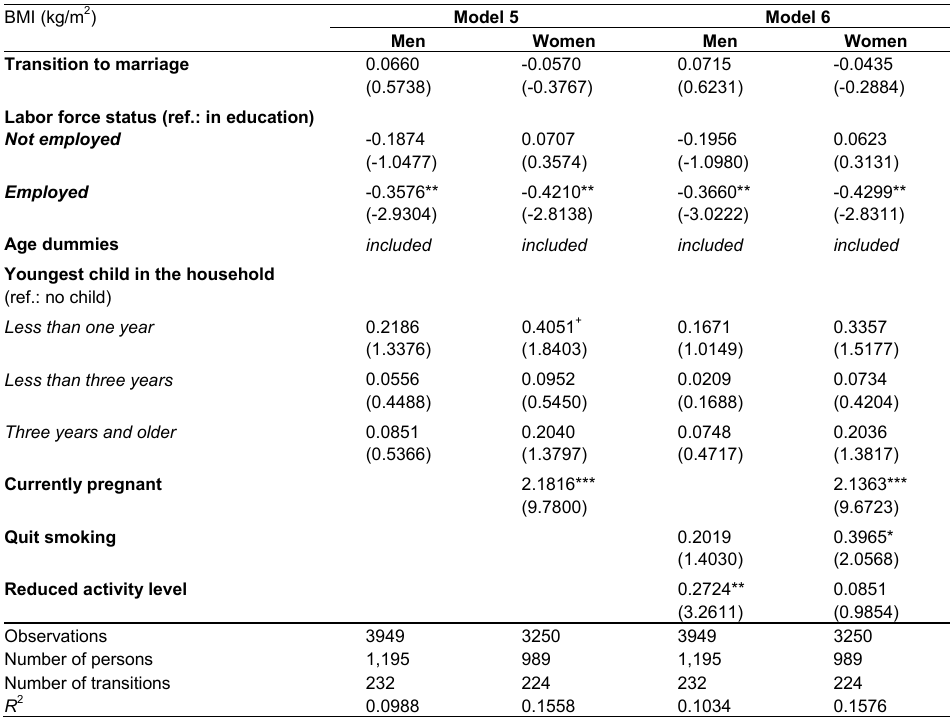
Table 5 : Fixed effects estimation results of transition from unmarried cohabitation to marriage on